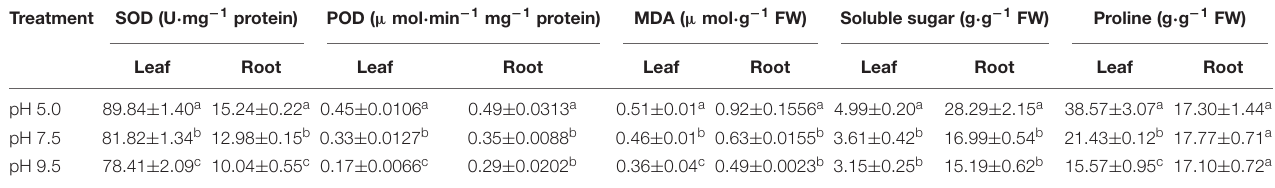
TABLE 2 | The activities of SOD and POD, and the amounts of MDA, soluble sugar and proline occurring in leaves and roots of sugar beet treated with different soil pH. Treatment SOD (U · mg − 1